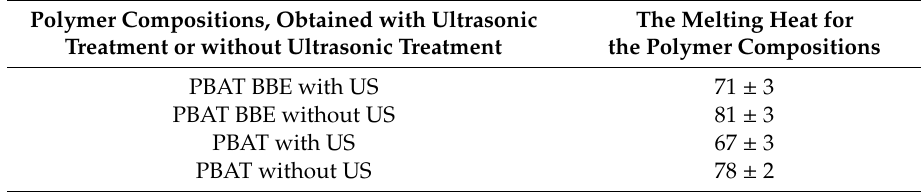
Table 5. The melting heat for polymer compositions.